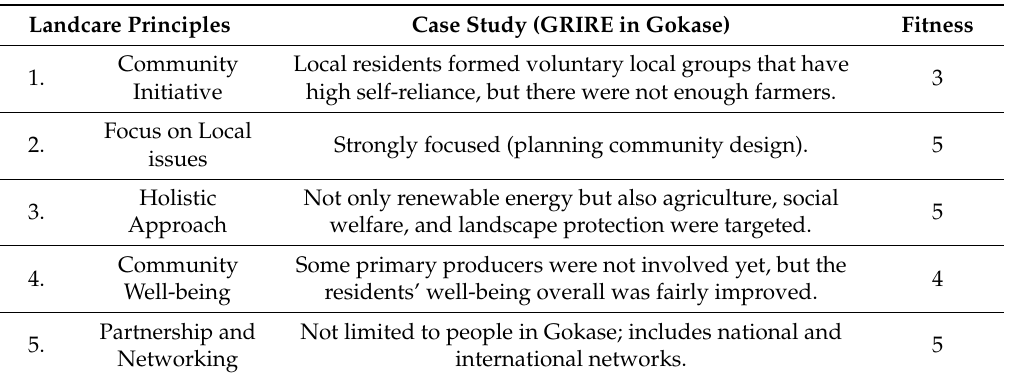
Table 1. Comparison and fitness between Landcare principles and the case of GRIRE (minimum score: 1; maximum score: